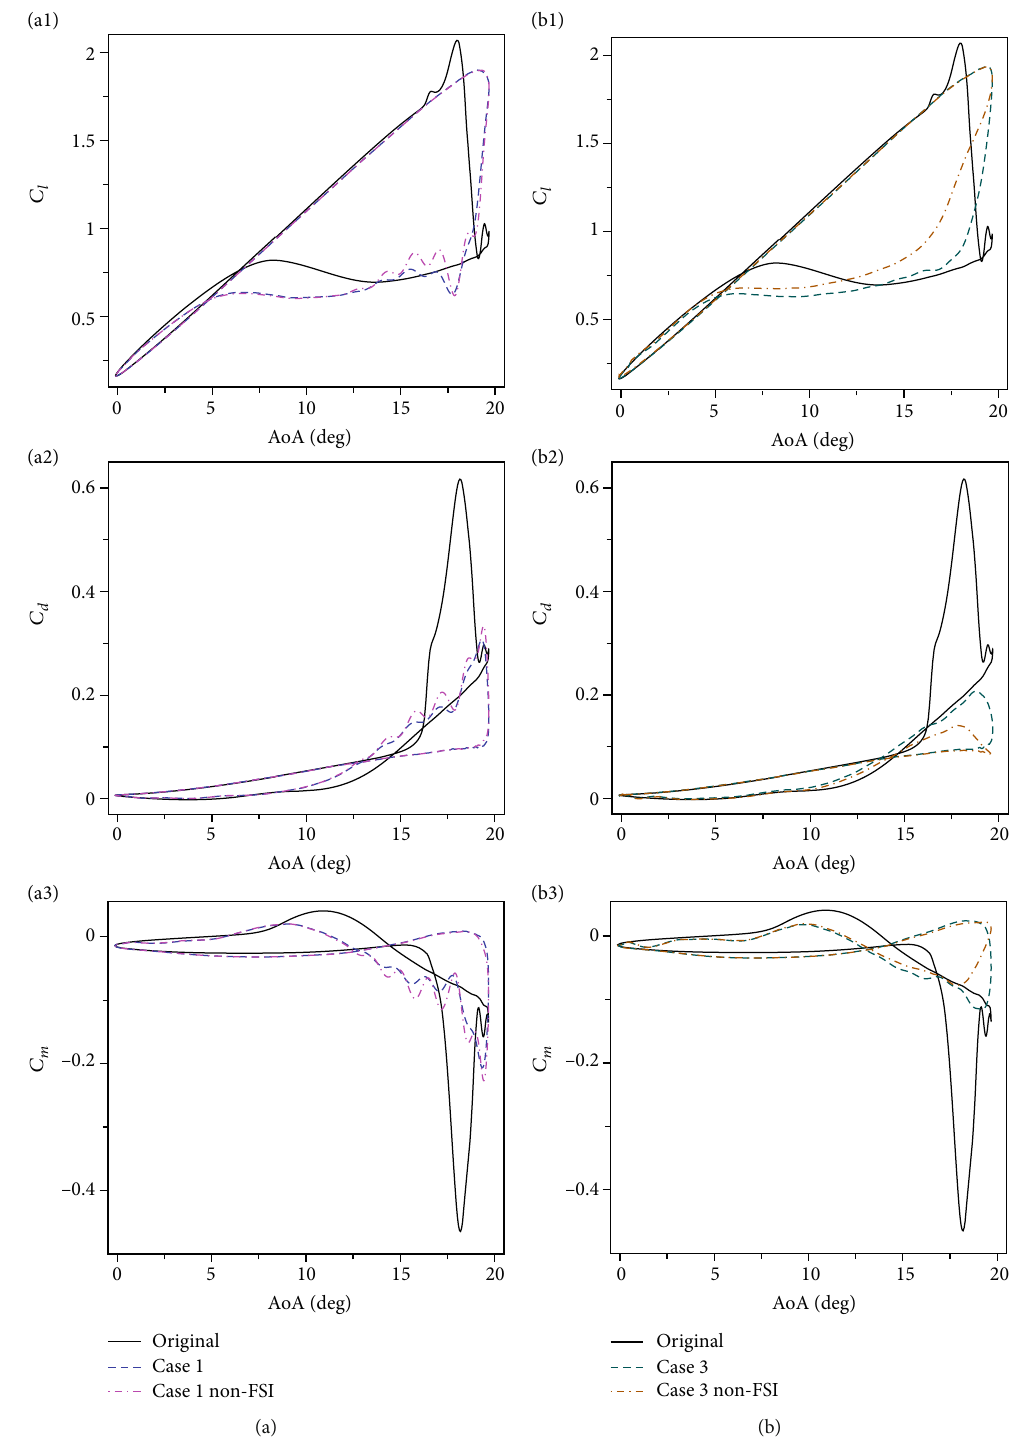
Figure 21: Comparison of aerodynamic coe ffi cients between di ff erent